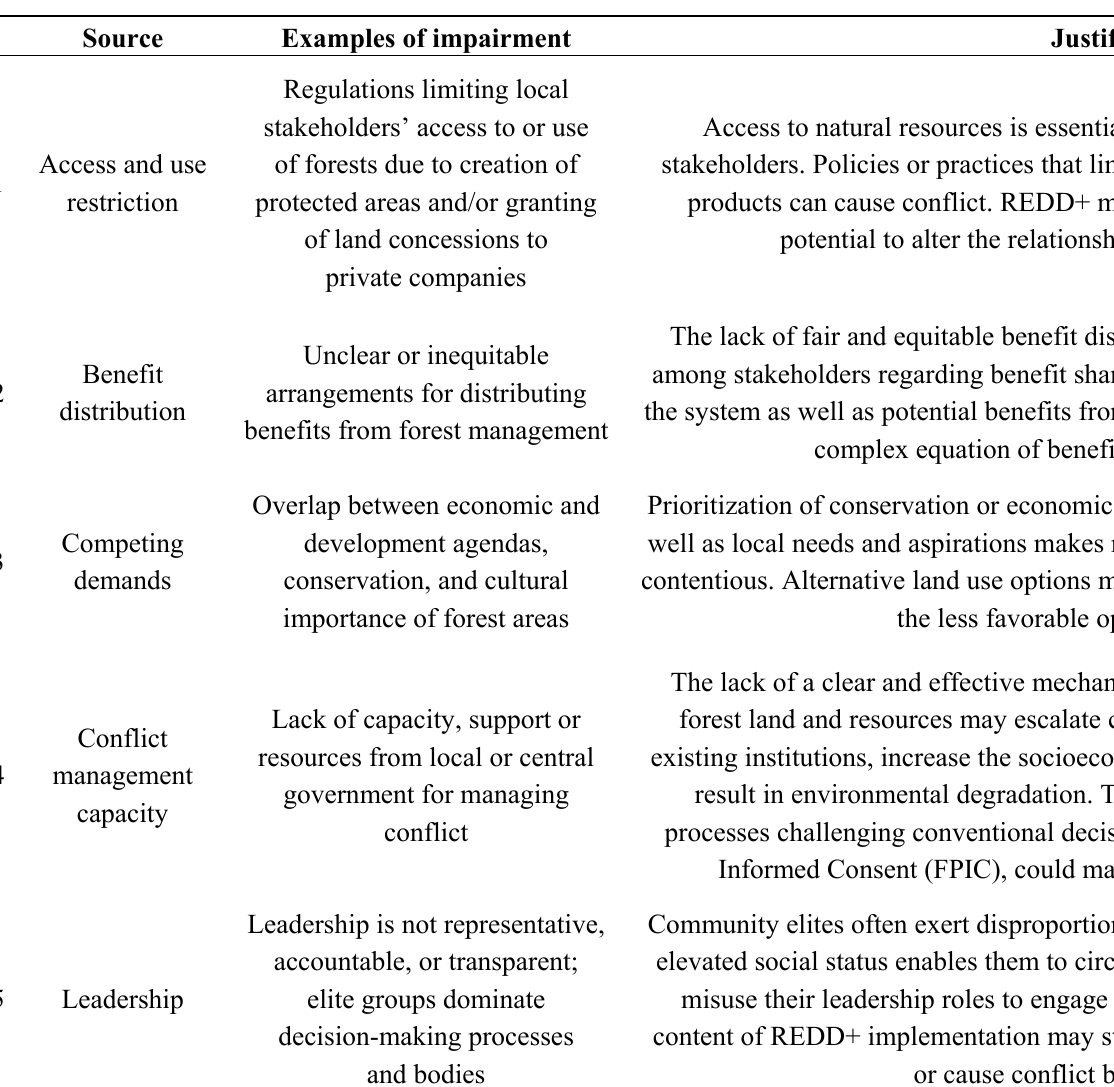
Table 2. Sources of